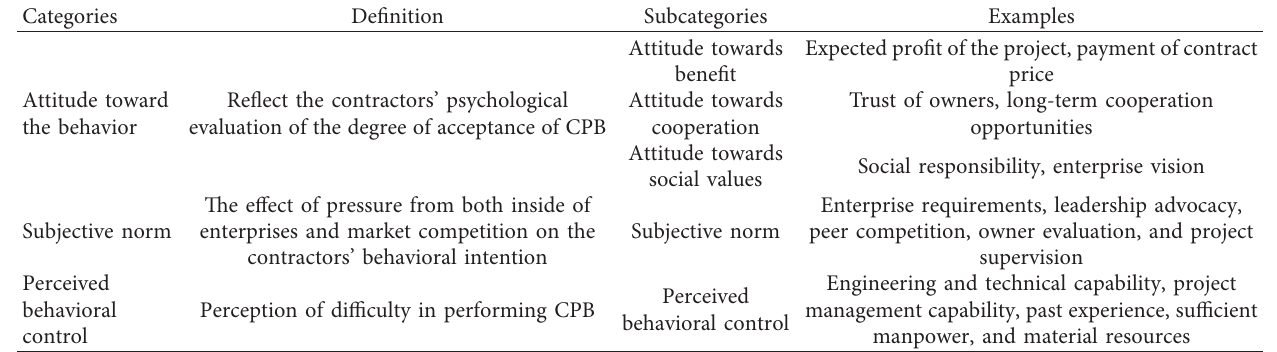
Table 1: The incentive factors of intention for consummate performance behavior.